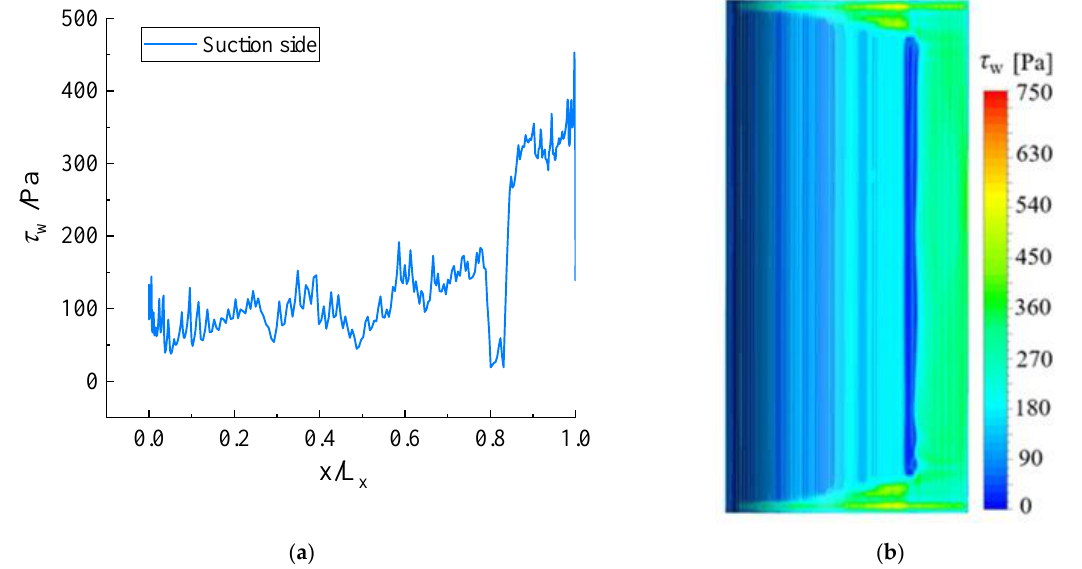
Figure 14. Distribution of wall shear on the suction surface. ( a ) Wall shear distribution at 50% blade height; ( b ) wall shear contour.